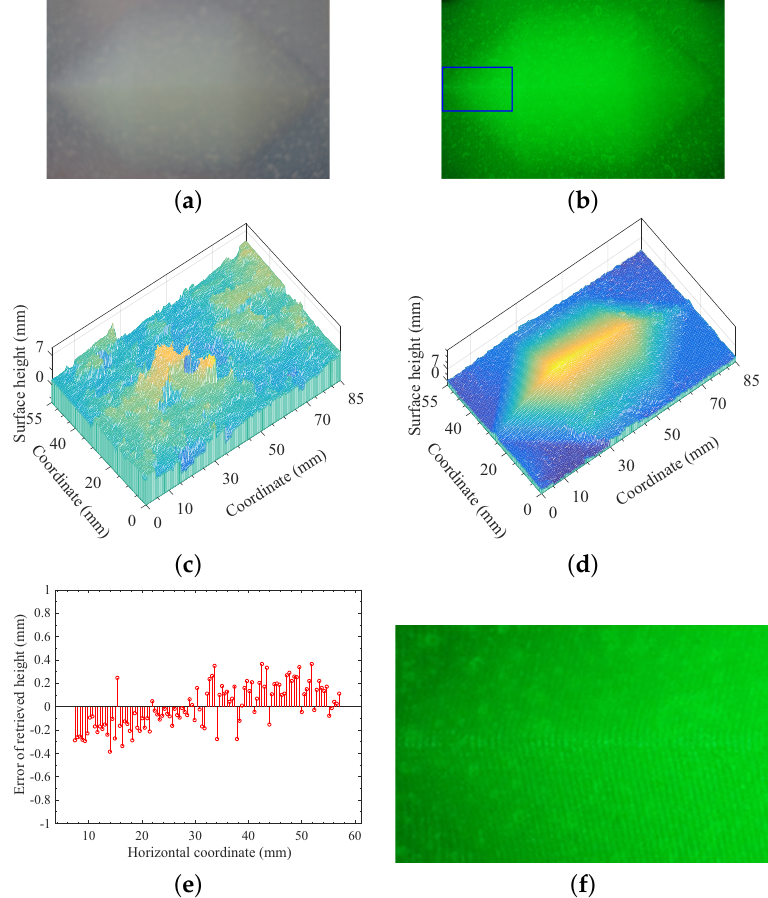
Figure 4. Measurement and reconstruction of the heptahedron-shape vulcanized silicone rubber illuminated by monochromatic sinusoidal fringe pattern at 532 nm under background illuminance E = 202 Lux. ( a ) Image without optical filtering. ( b ) Image with an optical bandpass filter centered at 532 nm with FWHM being 10 nm. ( c ) Reconstruction using the measurement of ( a ). ( d ) Reconstruction using the measurement of ( b ). ( e ) The absolute-error distribution of retrieved surface height on the cross section perpendicular to the ridge with actual values in accordance with data of ( d ). ( f ) The enlarged figure of the marked blue-rectangle region in ( b